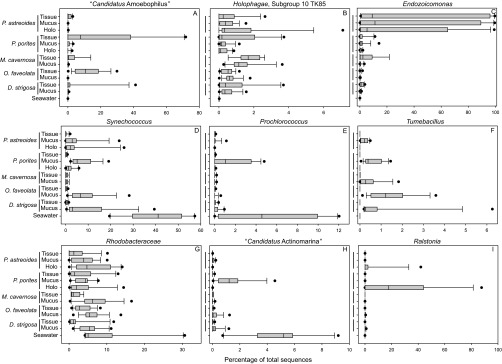
Boxplots displaying relative percent abundance of consistent abundance-based microbiome members present in the tissue, mucus, and holobiont (Holo) fractions of the different coral species (n = 12 to 15) as well as seawater samples (n = 10). Boxes display the first and third quartile spread of the data, with the line in the box indicating the median and the whiskers denoting the minimum and maximum values. Note the different scales on the x axes.